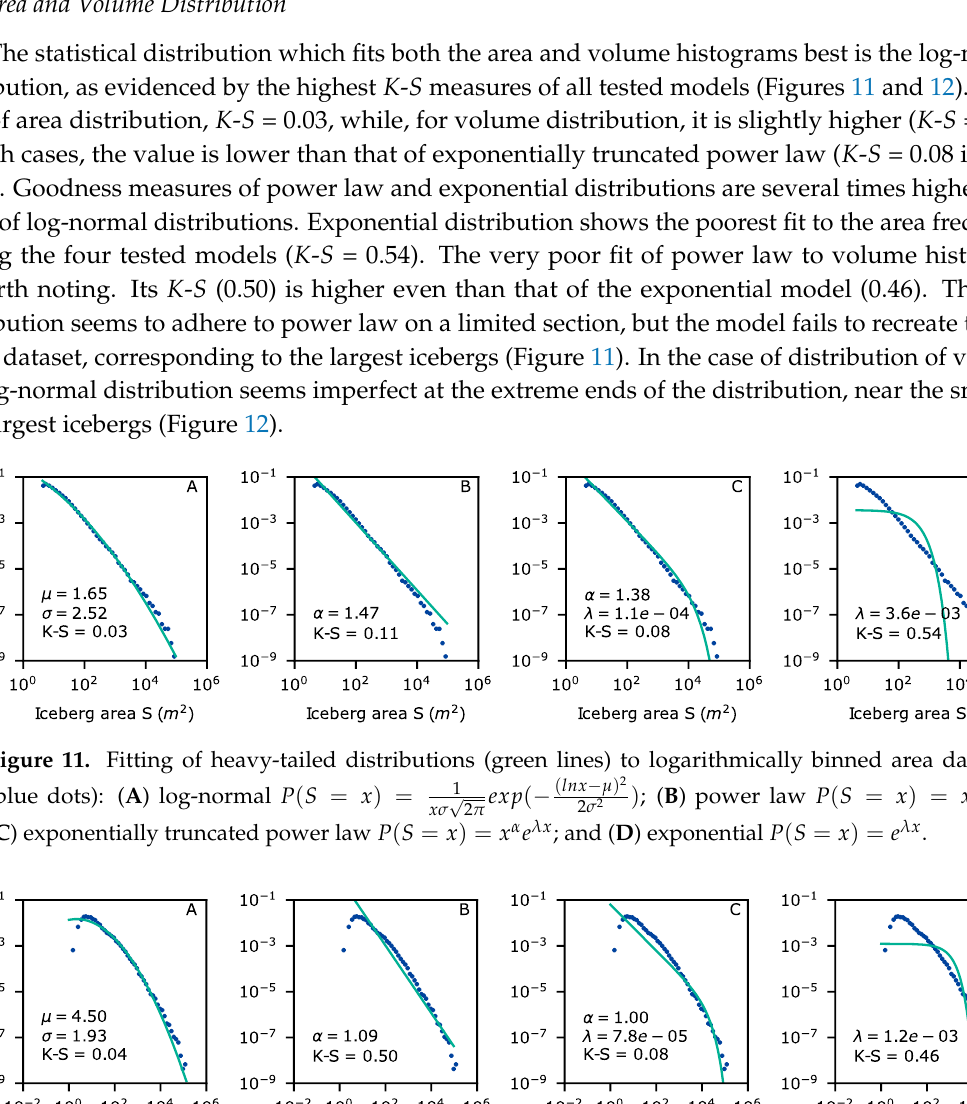
Figure 12. Fitting of heavy-tailed distributions (green lines) to logarithmically binned volume data (blue dots): ( A ) log-normal P ( V = x ) = 1 ( C ) exponentially truncated power law P ( V = x ) = x α e λ x ; and ( D ) exponential P ( V = x ) = e λ x